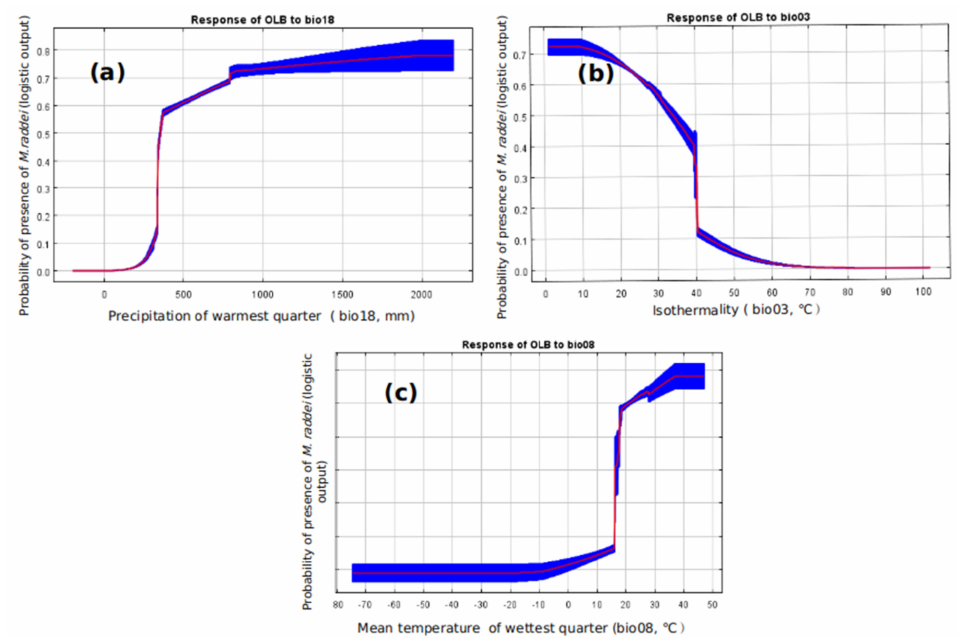
Figure 3. Response curves of the key climatic variables to the presence probability of M. raddei (OLB) in the MaxEnt model (precipitation of the warmest quarter ( a ); isothermality ( b ); mean temperature of the wettest quarter ( c